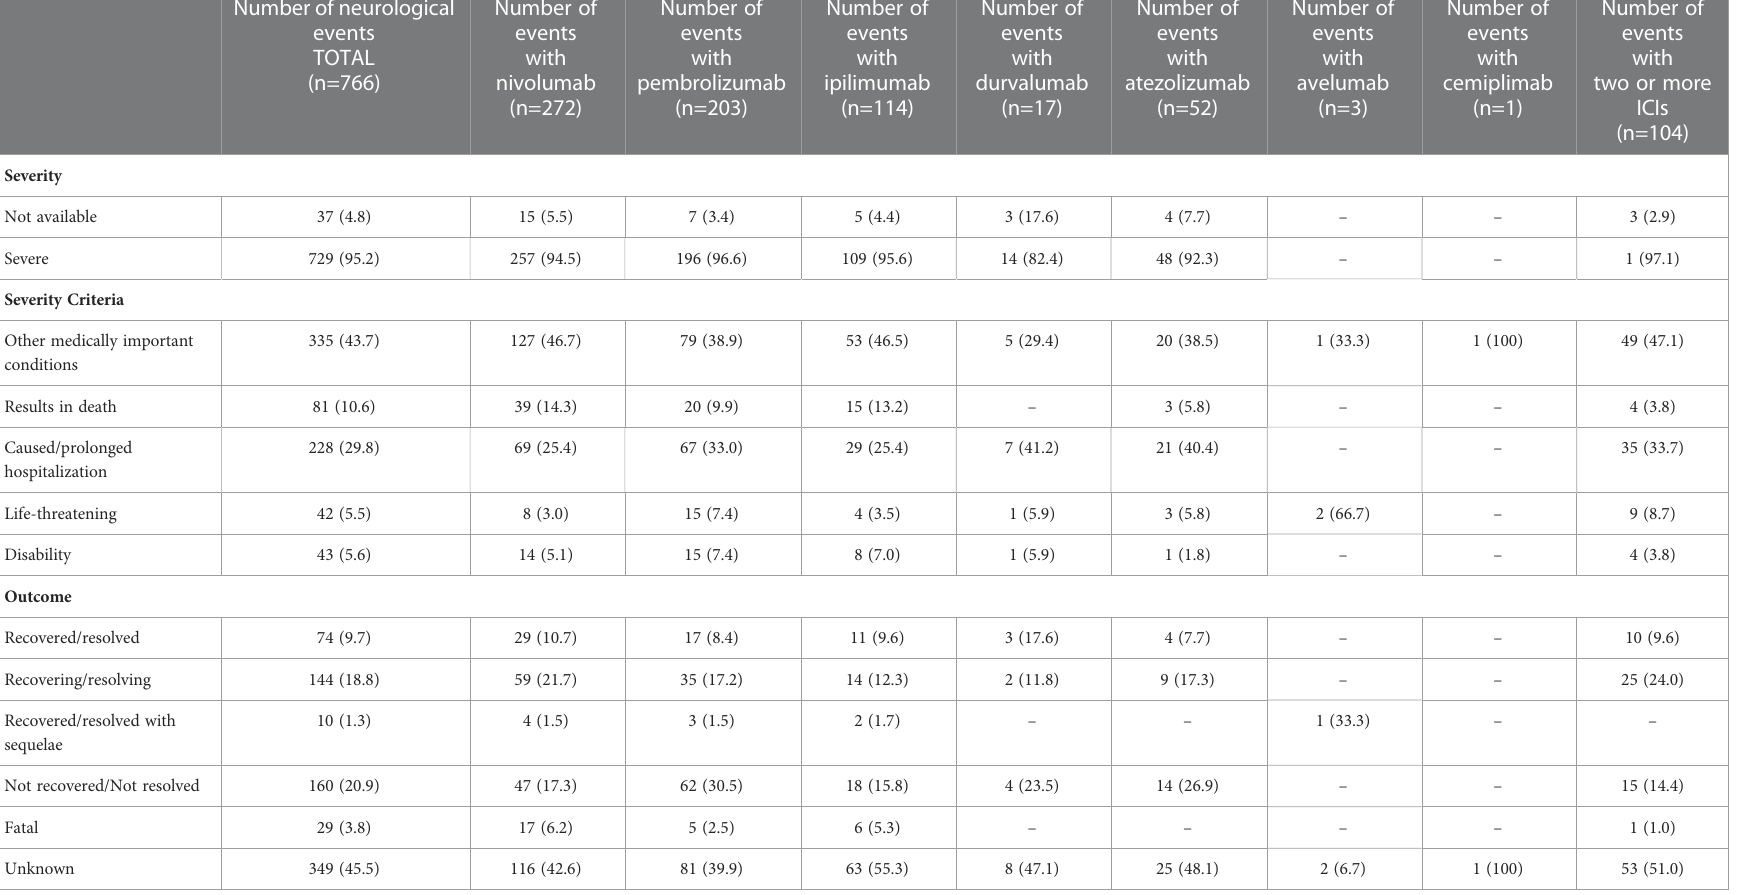
TABLE 3 Distribution of severity and outcomes of neurological complications occurred in European patients treated with at least one